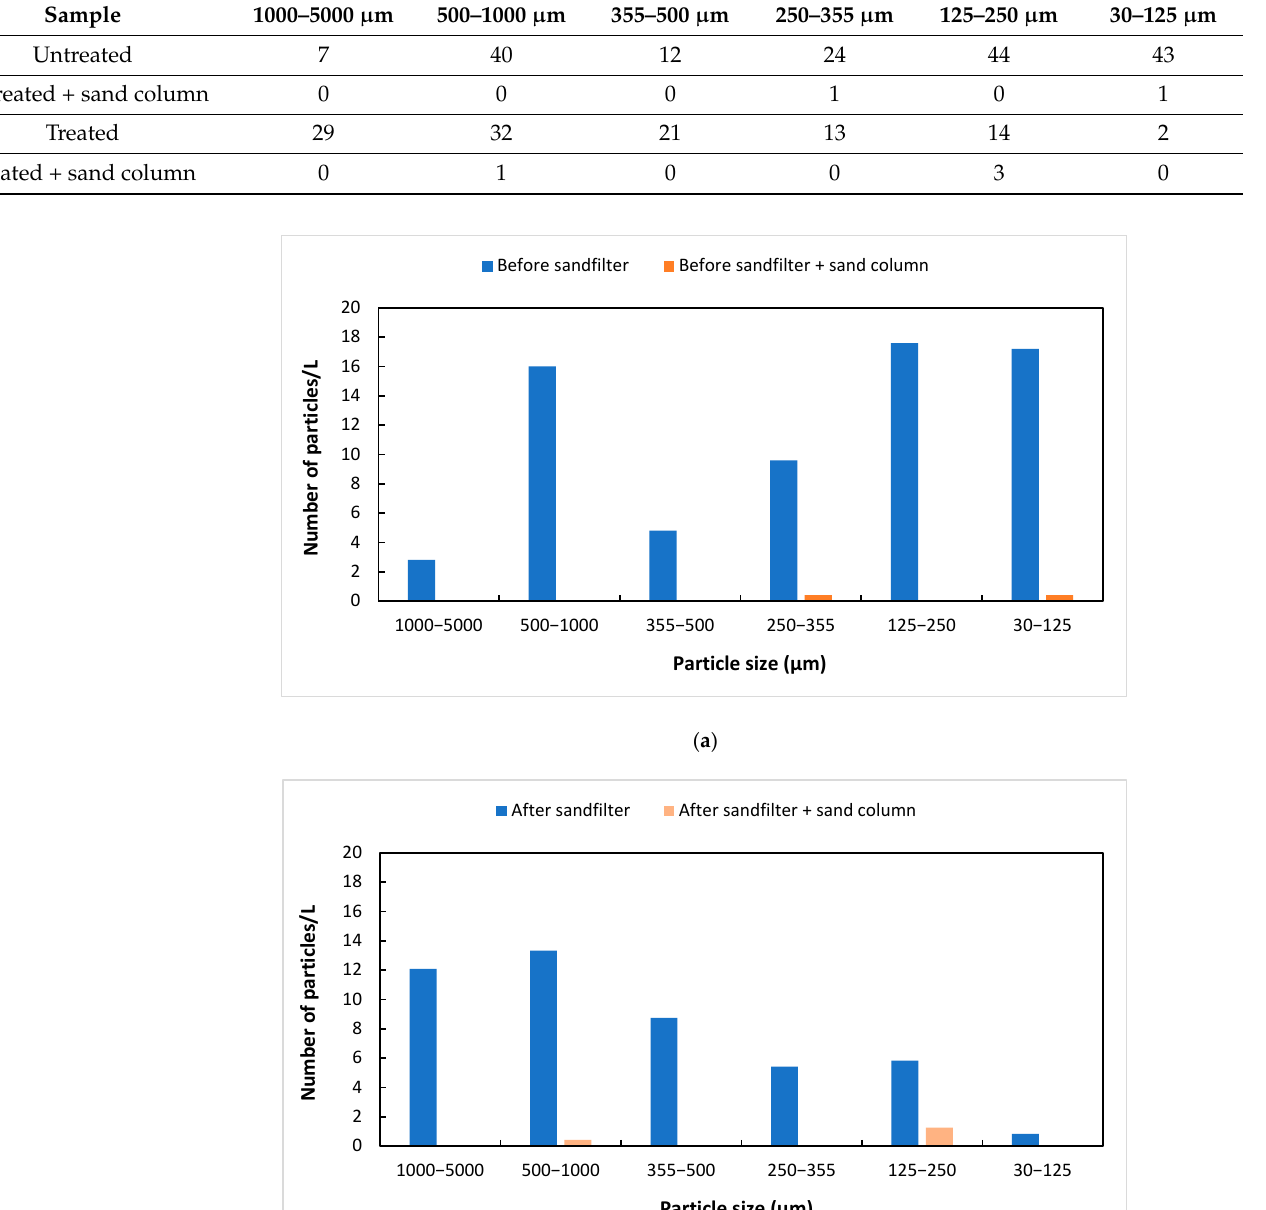
Table 3. Total number of fragments, before and after the sand-filter.